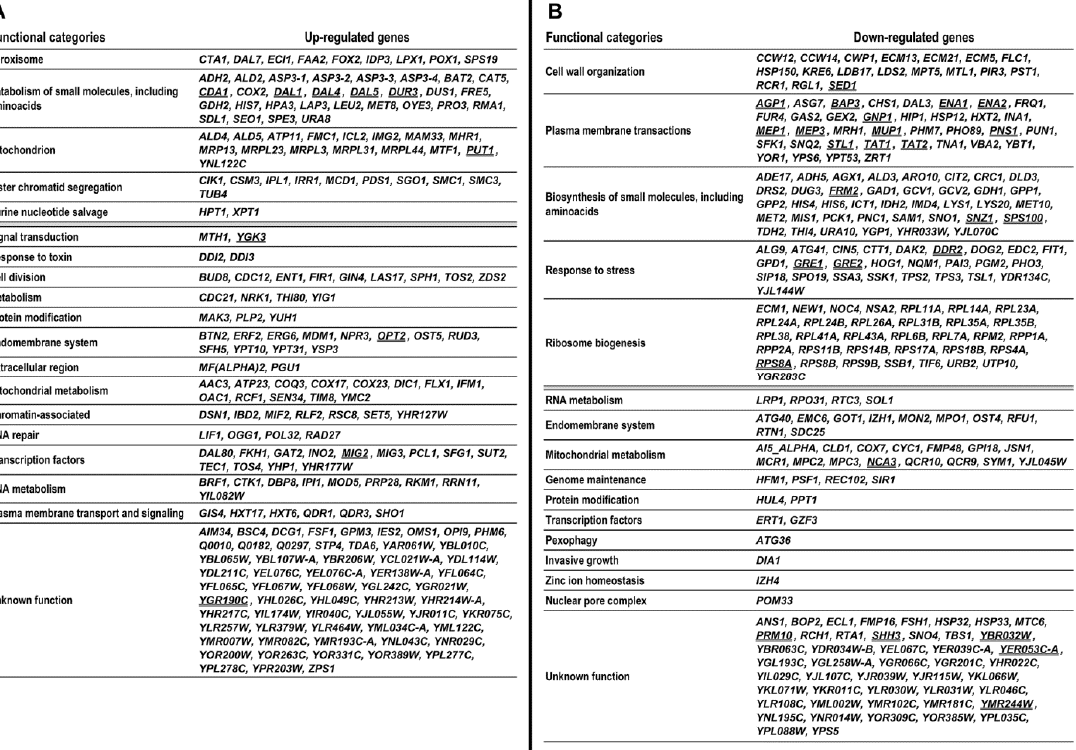
Figure 2. All upregulated ( A ) and downregulated ( B ) genes selected in the course of transcriptome analysis sorted according to the functional category assigned to them. For clarity, the number of GO terms, shown in Figure 1, was reduced by merging the lists of genes of similar functions. Sorting was performed manually based on GO annotations assigned to genes and the descriptions of their functions in the Saccharomyces Genome Database (SGD). Below the gray bar are genes whose functions were not overrepresented within the gene sets. Genes with LogRatio above 2.33 or below − 2.33, i.e., whose expression changed at least 5-fold, are marked in bold face. See Figure S3 for the expanded version of this figure listing genes together with the short descriptions of their functions taken from SGD.